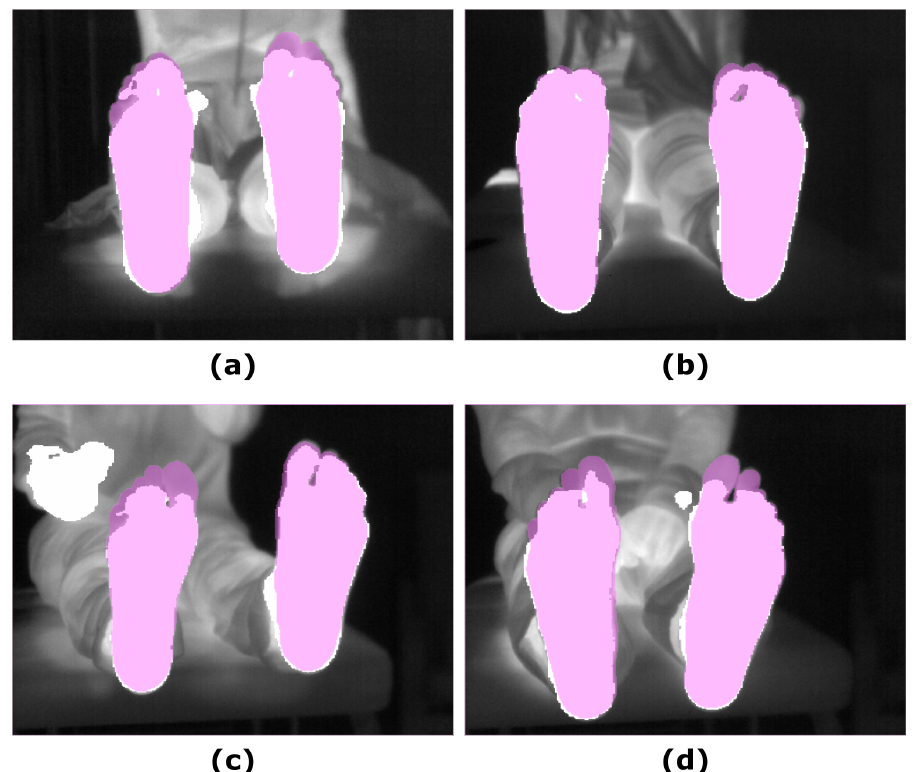
Figure 5. Illustrative examples showing the final prediction for the SegNet approach ( α = 1): ( a ) IR input image and the best prediction at T0; ( b ) IR input image and the best prediction at T5; ( c ) IR input image and worst prediction at T0; ( d ) IR input image and worst prediction at T5. The ground truth (pink mask), was overlapped to both, the IR and the final prediction (white mask).